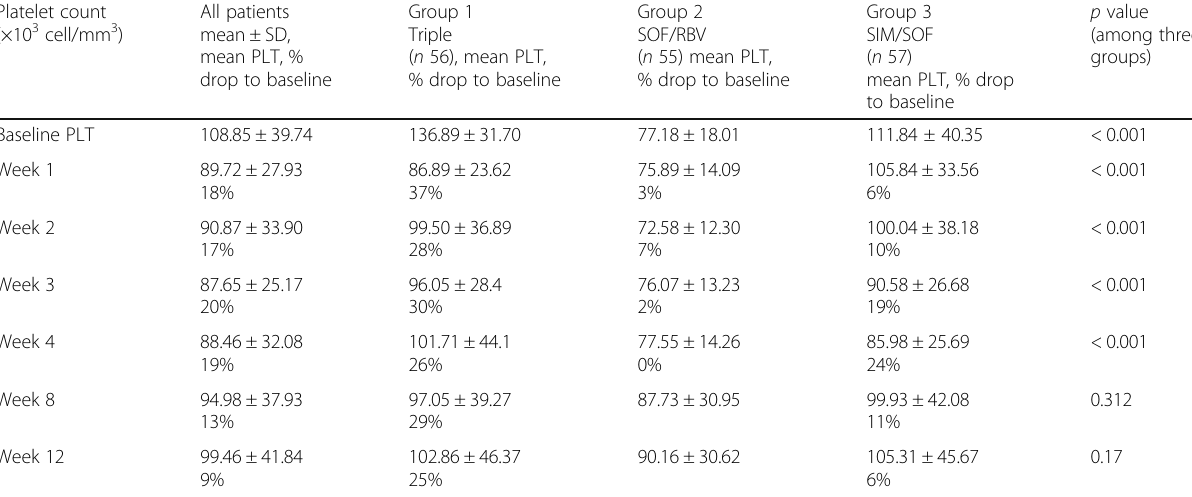
Table 4 Mean platelet count in diffrent weeks of treatment Platelet count (×10 3 cell/mm 3